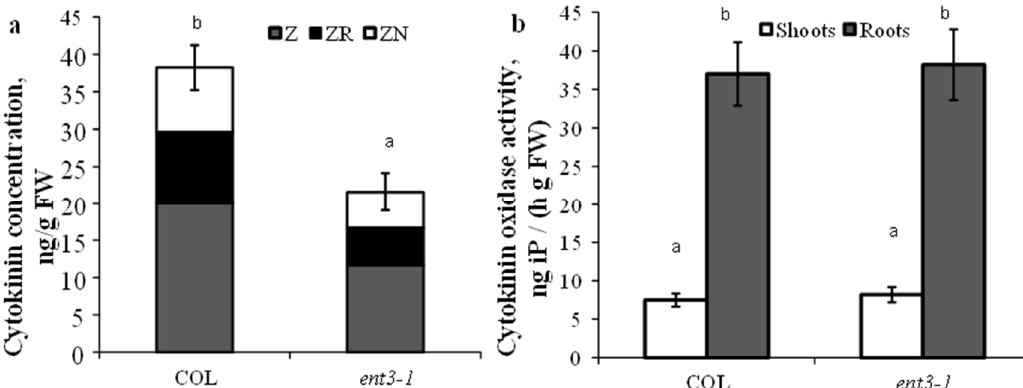
Figure 1. Concentration of zeatin (Z), zeatin riboside (ZR), and zeatin nucleotide (ZN) in roots ( a ) and cytokinin oxidase activity ( b ) in hydroponically grown 4-week-old ent3-1 Arabidopsis mutant and its parent ecotype Columbia (Col). Statistically differing means (n = 6) are indicated with different letters ( p < 0.05, Student’s t -test).